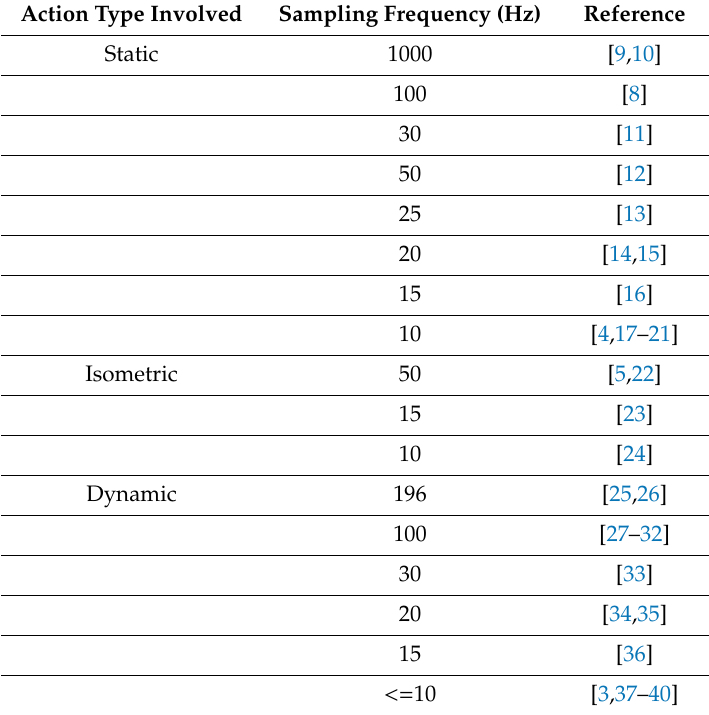
Table 1. FMG sampling frequency reported in the